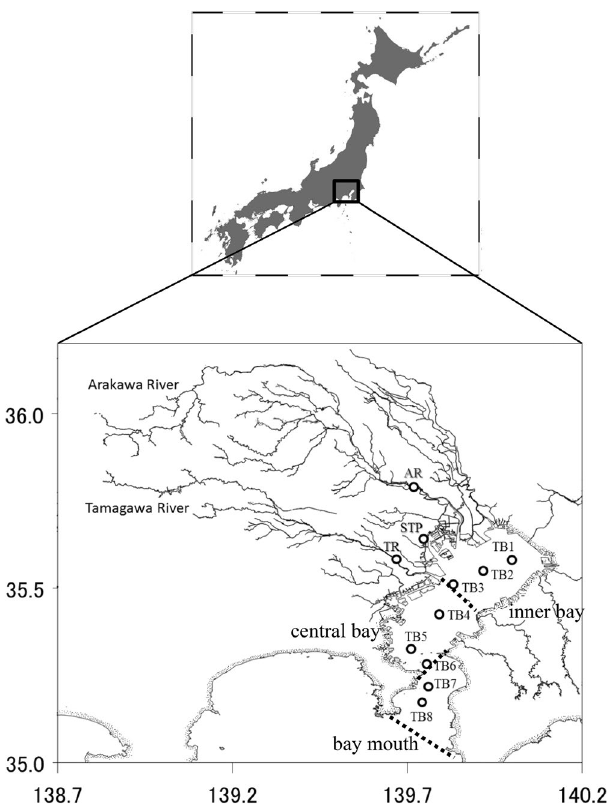
Figure 1. Study area in Tokyo Bay. Black circles indicate sampling locations. Broken lines show box-model cross-sections. The map was created using Surfer (version 13.6.618; https ://www.golde nsoft ware.com/produ cts/ surfe